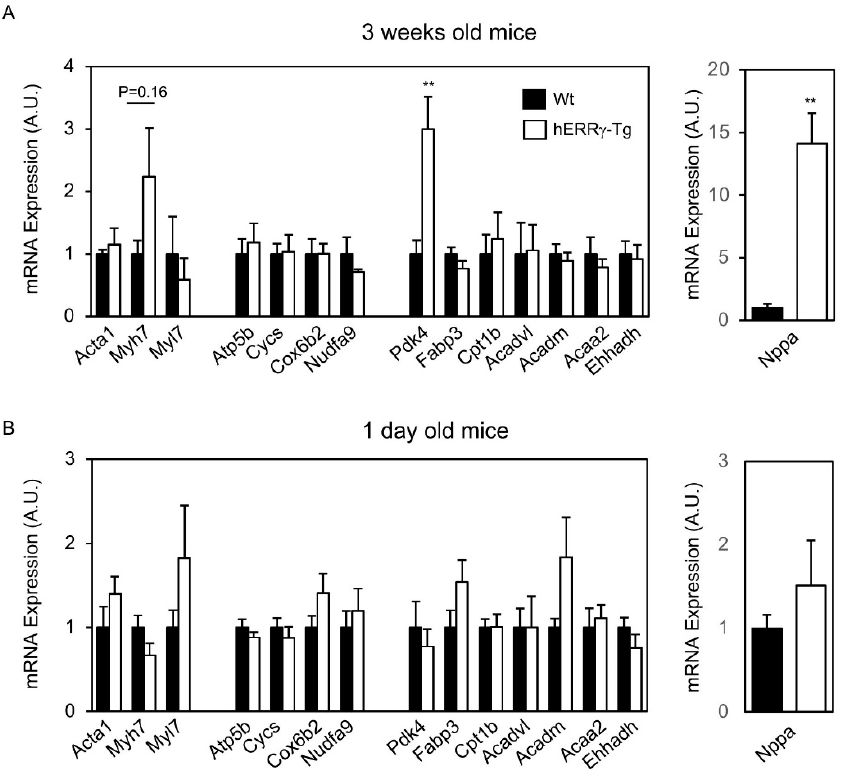
Figure 7. Expression of ERR γ target genes in young L6 hERR γ -Tg mice. mRNA expression of genes related to sarcomeric proteins, OxPhos system, and lipid metabolism, as well as Nppa, was determined by real-time quantitative PCR in 3-week-old ( A ) and 1-day-old ( B ) hERR γ -Tg mice and Wt littermates. Data are mean ± SEM of 3–5 animals/group; ** p = 0.01.